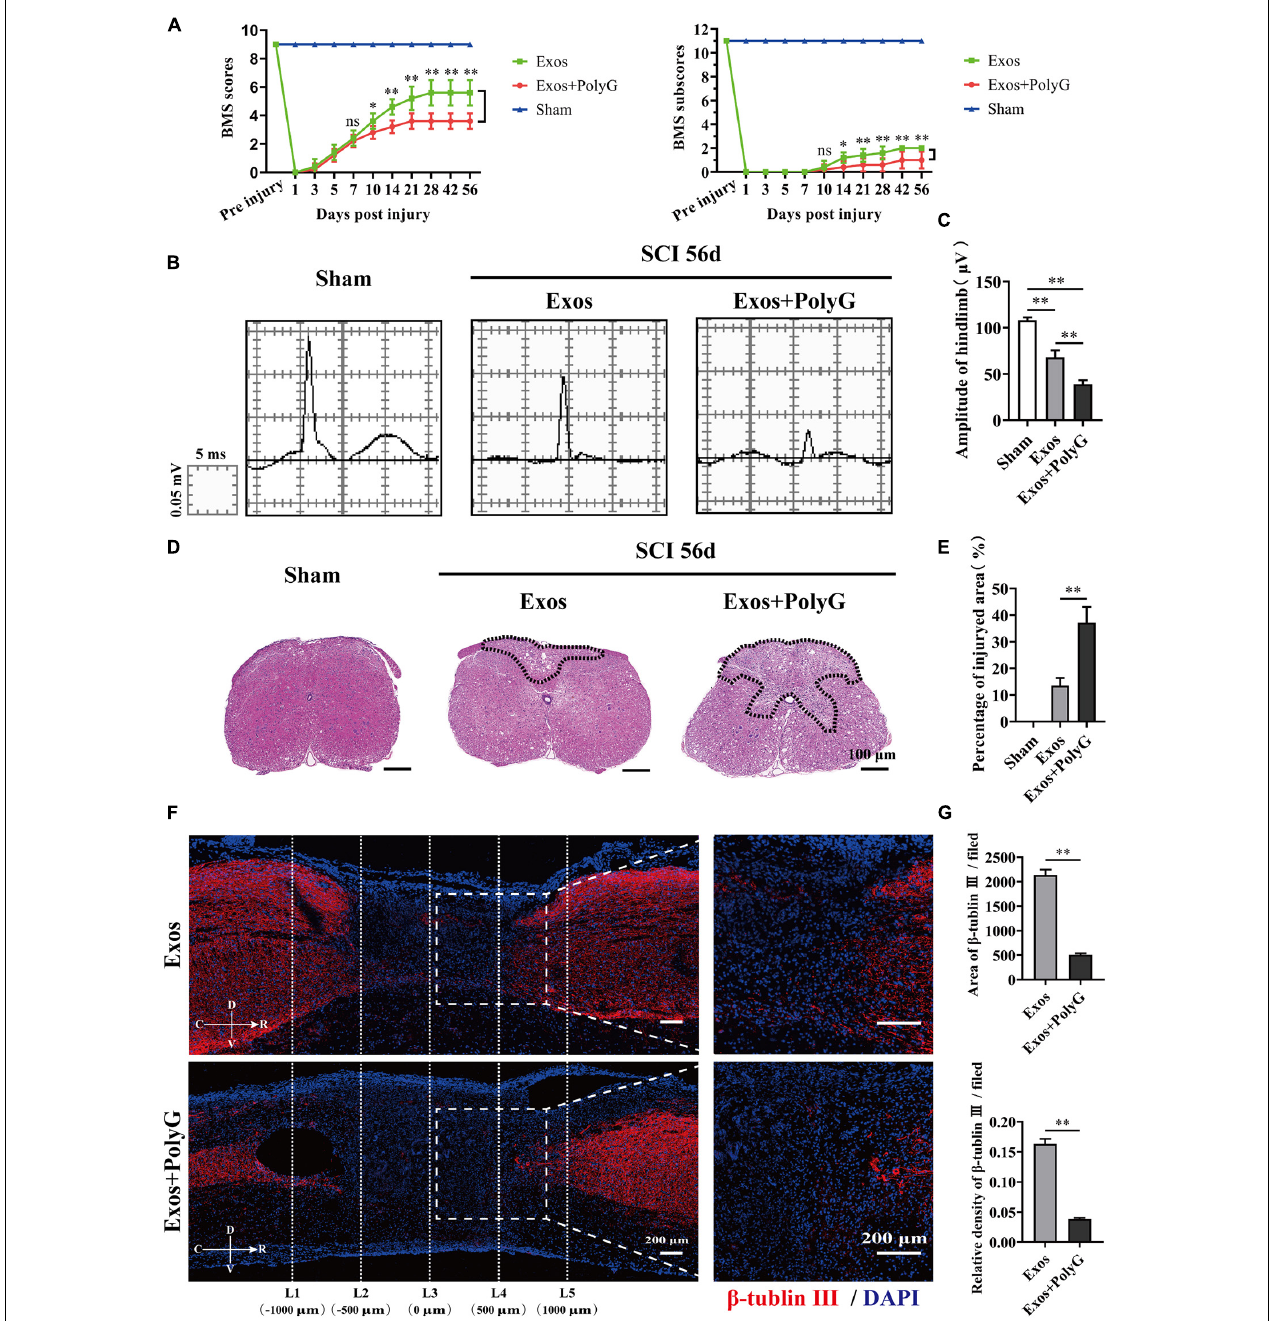
FIGURE 9 | Blocking macrophage receptor with collagenous structure (MARCO) impaired the ability of bone marrow mesenchymal stem cell-derived exosomes (BMSC-Exos) to promote neurological functional recovery and tissue repair after spinal cord injury (SCI). (A) Basso Mouse Scale (BMS) scores and BMS subscores over time post-SCI in the sham, Exos, and Exos + PolyG groups. n = 5 per group. (B) Representative images of motor evoked potentials (MEPs) in the sham, Exos, and Exos + PolyG groups at 56 days post-SCI. (C) Quantification of amplitude of hindlimb in (B) ( n = 5 per group, values are the mean ± SD, ∗∗ p < 0.01, one-way ANOVA). (D,E) H&E staining and quantification of the lesion site in the sham, Exos, and Exos + PolyG groups at 56 days post-SCI. The black dashed line outlines the damage area. Scale bar = 100 µ m ( n = 5 per group, values are the mean ± SD, ∗∗ p < 0.01, two-tailed Student’s t -tests). (F) Representative immunofluorescence images of the axon marker β -tubulin III (red) in the Exos and Exos + PolyG groups at 56 days post-SCI. Nuclei were counterstained with DAPI (blue). The white dashed line outlines the distance rostrally or caudally from the injured epicenter of the injured spinal cord. White dashed rectangular frames of ROI are selected for quantitative analysis of the axon area and density among different treatment groups. Scale bars = 200 µ m. (G) Immunofluorescence semiquantification of the area and relative density of β -tubulin III (red) within the ROI in the spinal cord at 56 days post-SCI in (F) ( n = 5 per group, values are the mean ± SD, ∗ p < 0.05, ∗∗ p < 0.01, one-way ANOVA). ROI, region of